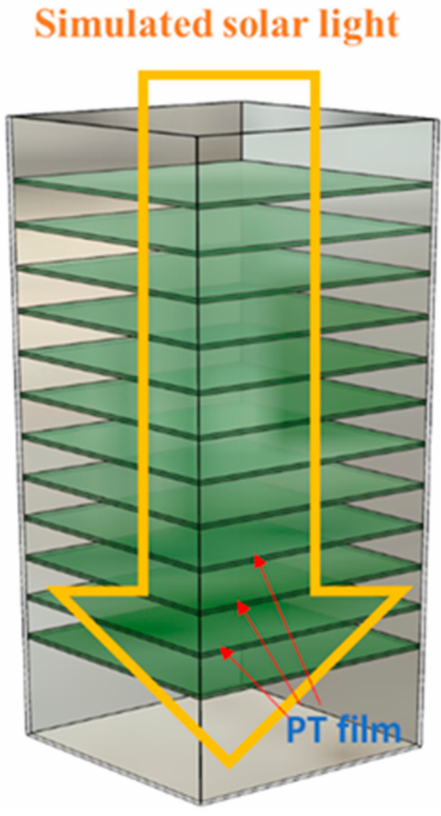
Figure 5. The multilayer 3D solar harvesting photothermal energy generator [62]. Reprinted with permission from Lyu, Mengyao, Jou Lin, John Krupczak, and Donglu Shi. “Solar harvesting through multilayer spectral selective iron oxide and porphyrin transparent thin films for photothermal energy generation.” Advanced Sustainable Systems 5, no. 6 (2021): 2100006. Copyright 2023 John Wiley and